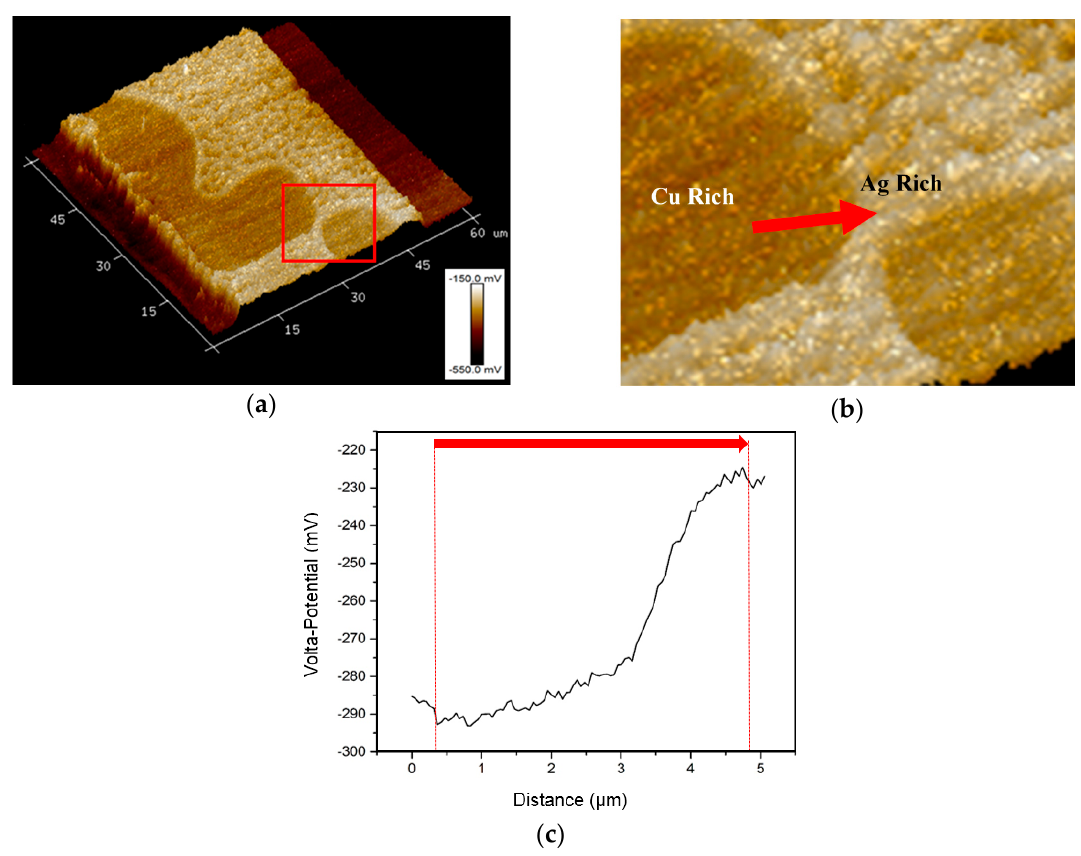
Figure 11. ( a ) Three dimensional (3-D) SKPFM Volta potential image of Cu-Ag-Ti sample with a box indicating area of scan; ( b ) Zoomed in image with arrow indicating where scan was taken; and ( c ) Graph of potential values obtained from scan as a function of distance with indicating arrow.